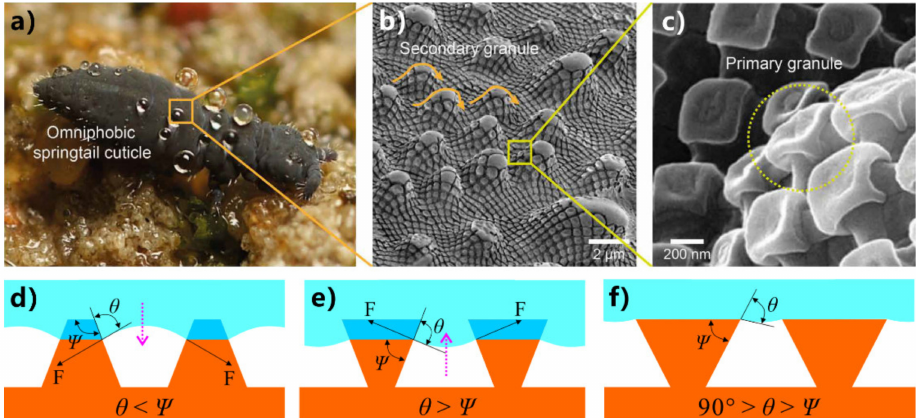
Figure 5. Liquid repellency of a springtail. ( a ) Photograph of a springtail. ( b , c ) Surface microstructure of springtail skin. Reprinted from ref. [163]. ( d – f ) Importance of the re-entrant structure in the achievement of in-air superoleophobicity: ( d , e ) hypothetical solid-air-liquid interfaces on ( d ) a trapezoid texture and ( e ) an inverted-trapezoid texture, and ( f ) robust Cassie state of liquid with low surface tension on the inverted-trapezoid (re-entrant) texture. Reprinted from ref.